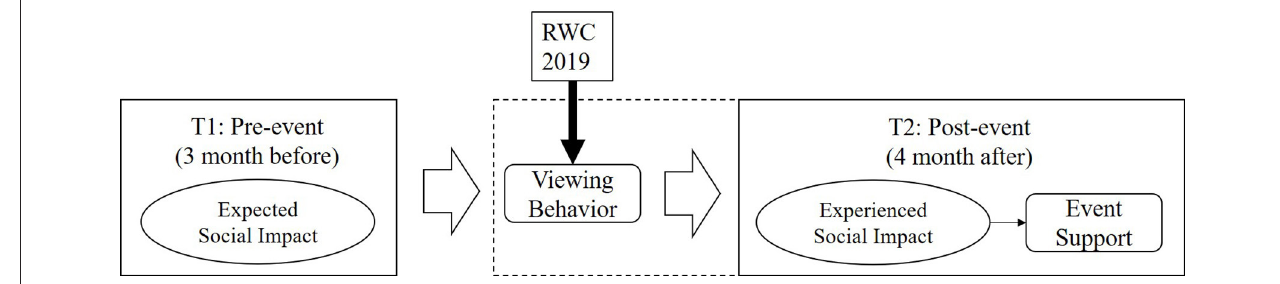
FIGURE 1 | Conceptual model. Dotted line: variable collected in